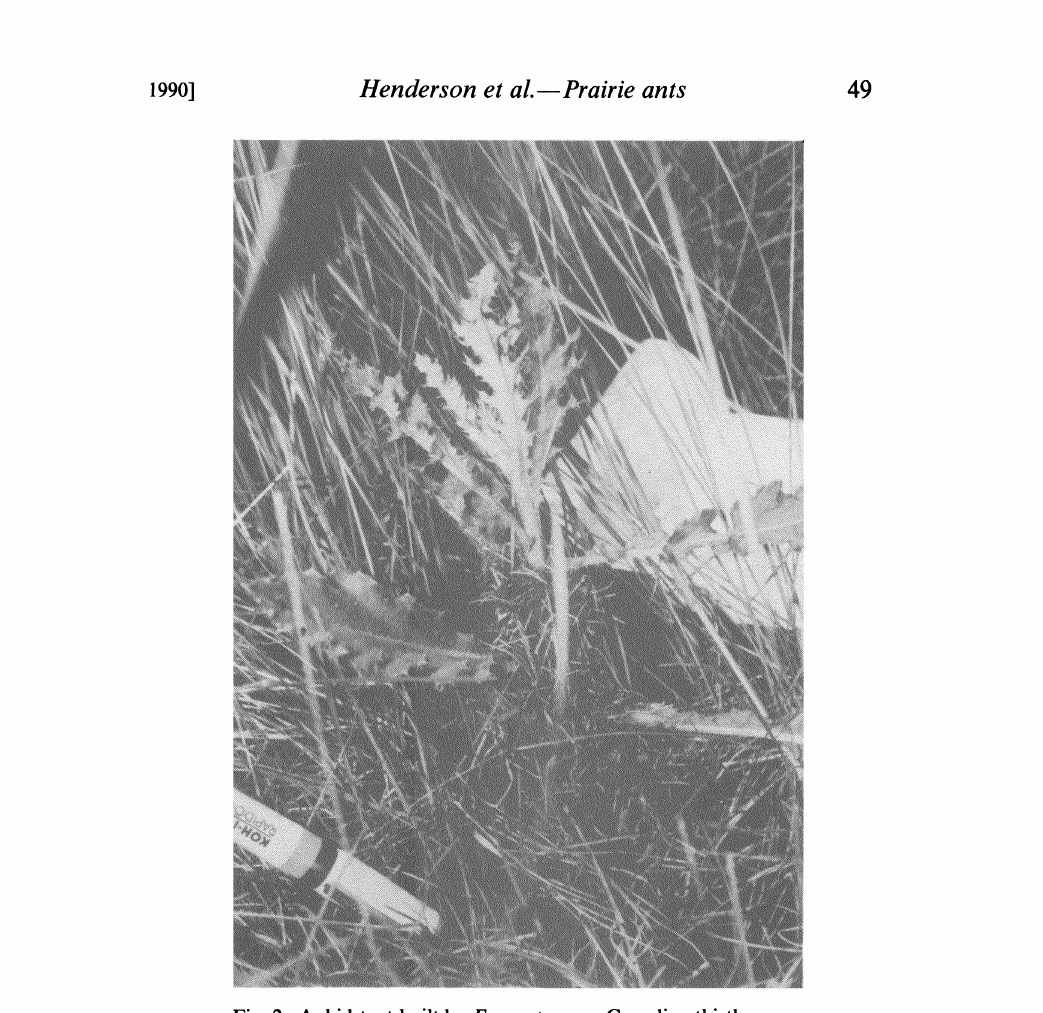
Fig. 2. Aphid-tent built by F. montana on Canadian